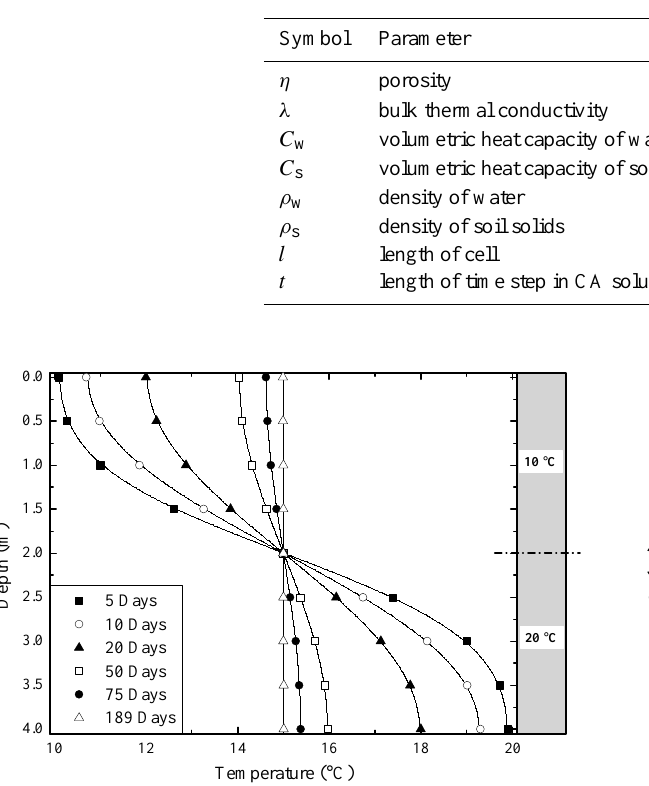
Figure 4. Comparison between the analytical solution given by Churchill (1972) and coupled cellular automata model simulation for a perfectly thermally insulated 4m long soil column. Lines rep- resent the analytical solution and symbols represent the CA solution for time points as shown in the legend. The initial temperature dis- tribution is shown on the right.